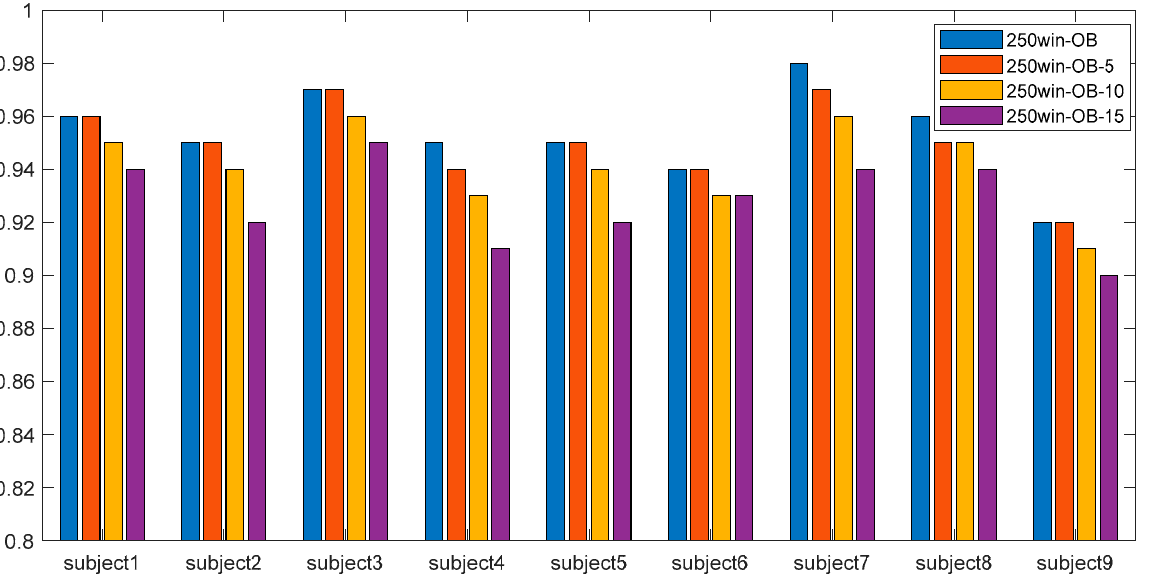
Figure 10. Change of kappa value according to channel removal.